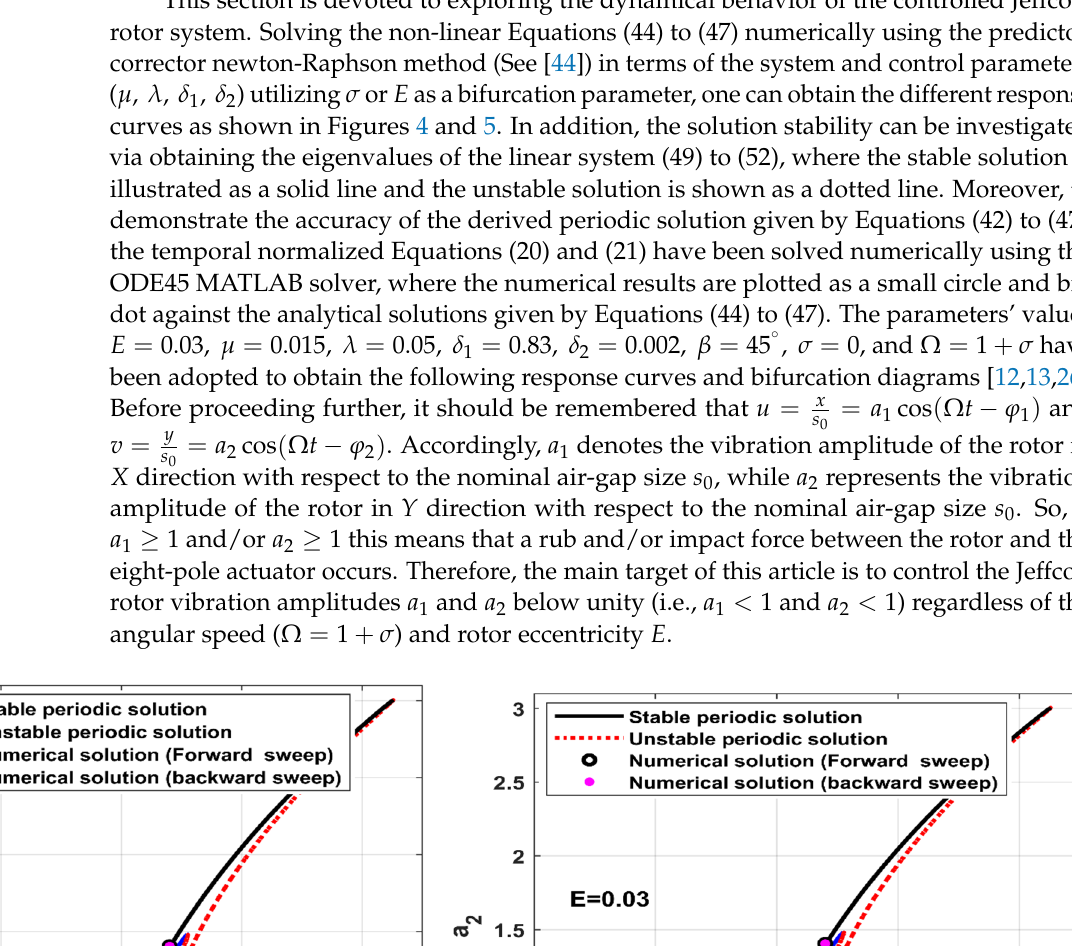
( b ) Figure 5. 𝐸 − response curves of the uncontrolled Jeffcott rotor at various values of 𝜎 : ( a ) oscillation amplitude in 𝑋 − direction ( 𝑎 (cid:2869) ) versus the eccentricity ( 𝐸 ), and ( b ) oscillation amplitude in 𝑌 − di- rection ( 𝑎 (cid:2870) ) the eccentricity ( 𝐸 ). 4.2. System Dynamics with Control ( 𝛽 (cid:3037) (cid:3405) 0, 𝑗 = 1,2, … ,10 ) According to the above discussions given in Section 4.1, the main objective of this article is to eliminate the non-linear behaviors of the considered Jeffcott-rotor (i.e., elimi- nate the hard-spring characteristic, jump-phenomenon, sensitivity to the initial condi- tions) via designing a suitable control system. Within this section, the non - linear interac- tions between the studied Jeffcott-rotor and the suggested control system (i.e., PD-con- troller and the 8-pole electro-magnetic actuator) have been explored. Figure 6 shows the controlled system oscillation amplitudes ( 𝑎 (cid:2869) , 𝑎 (cid:2870) ) against 𝜎 at three values of eccentricity